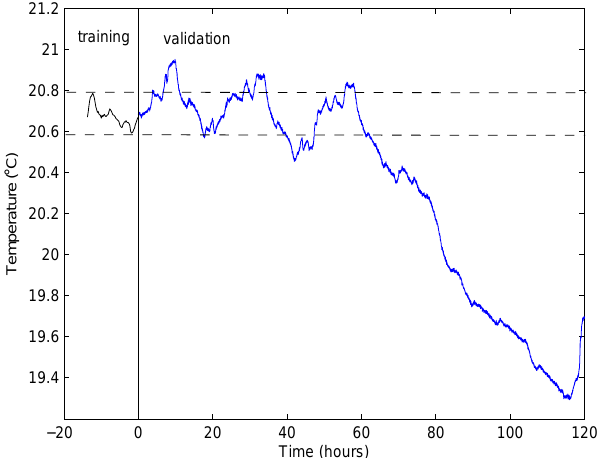
Figure 13. Evolution of the room temperature in five days.